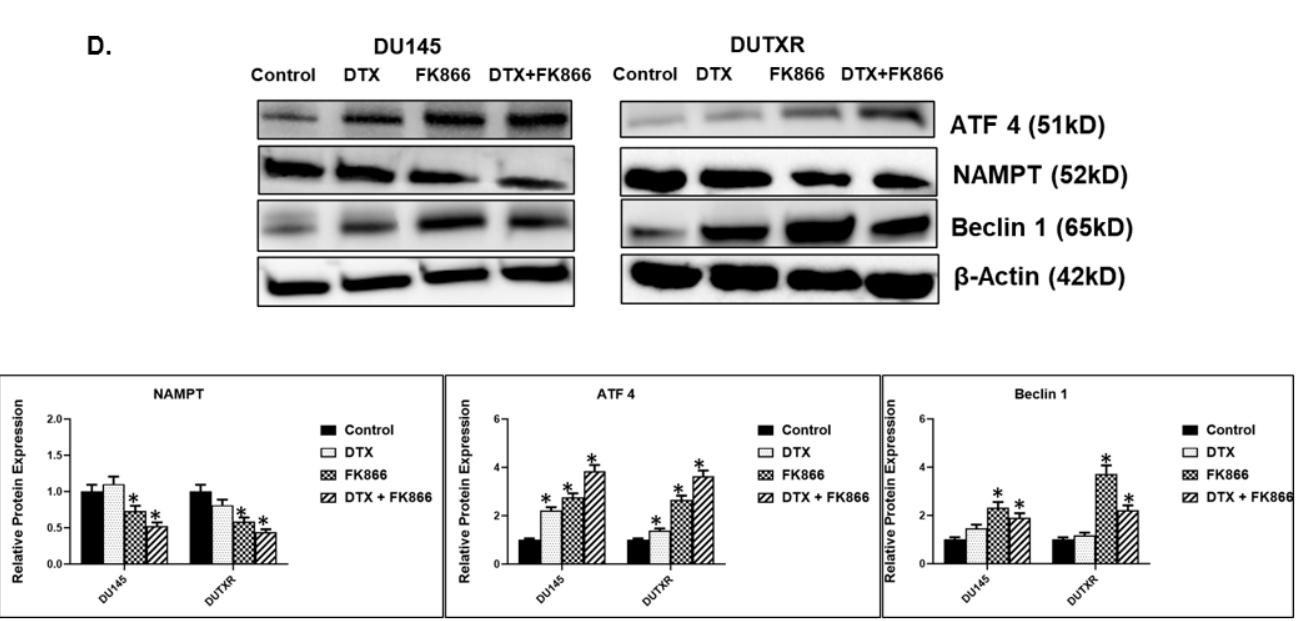
Figure 9. Functional validation of top key pathways. ( A ) Effect of FK866 treatments on Cell cycle: Representative figure showing results on the DU145 cell line. Cells were exposed to DTX, FK866, and DTX + FK866 treatment for 24 h, stained with propidium iodide (PI), and cell cycle phases were assessed by flow cytometry. Cell cycle stages were analyzed by CytExpert (Beckman Coulter). FK866 was shown to arrest cell cycle at the G2/M checkpoint. Cell Cycle in treatment groups was normalized to the corresponding control. (Significance p -value * = p < 0.05). Data are presented as the mean ± SEM of three separate experiments ( n = 5/study). ( B ) FK866 post-treatment ROS generation measured by DCFDA assay: ROS generation was measured after 2, 4, 8, and 24 h DTX, FK866 single- agent, and in DTX + FK866 combination treatments. ( C ) Mitochondrial Membrane Potential: FK866 treatment-induced mitochondrial dysfunction was measured by JC-1 Assay. ( D ) Western blotting and Densitometry analysis: Protein levels of FK866 target NAMPT, and ER stress and Autophagy markers Beclin-1 and ATF-4 were measured after DTX, FK866, and DTX + FK866 treatment. Post-treatment FK866 exhibited downregulation of NAMPT, and upregulation of Beclin-1 and ATF-4 compared to control (no drug treatment). (Significance p -value * = p < 0.05.) Original uncropped western blot images are provided in Supplementary Figure